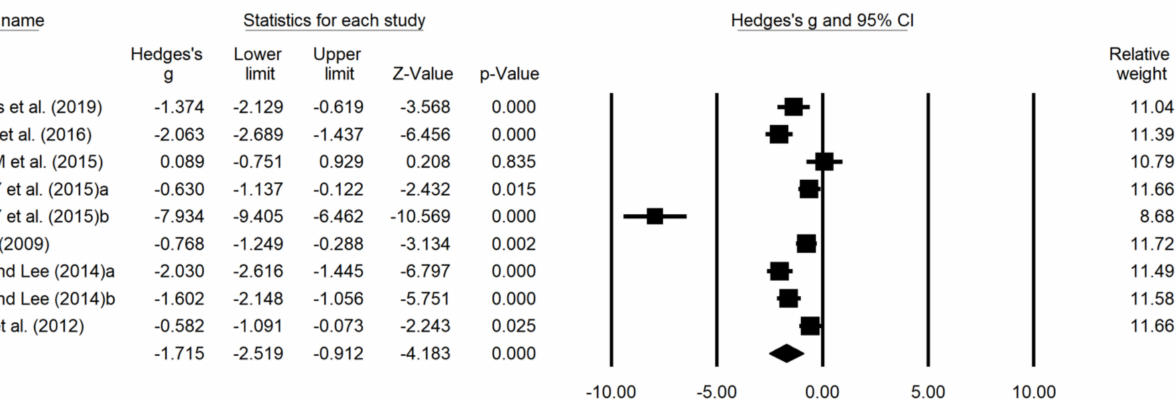
Figure 4. Forest plot the effects of forest therapy on anxiety. Heterogeneity: Tau 2 = 1.374; Q = 120.259; I 2 = 93.35%; Test overall effect Z = − 4.183 ( p <